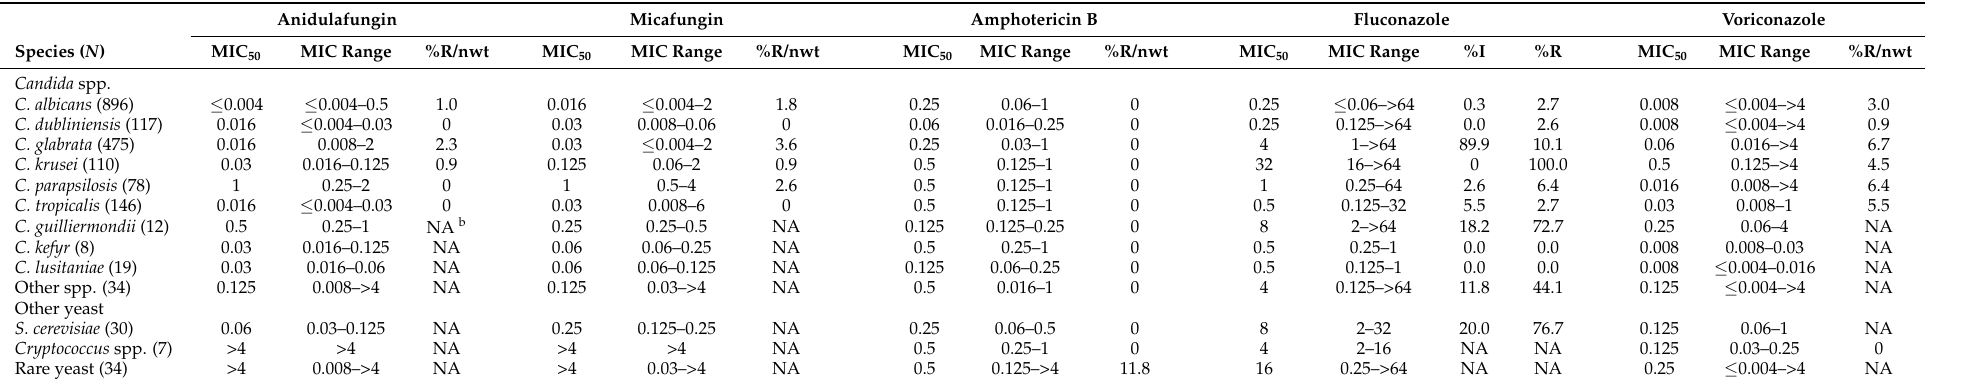
Table 6. Susceptibility characteristics given as MIC 50 and MIC range (both mg/L) and percentage of isolates classified as I (susceptible, increased exposure) a and